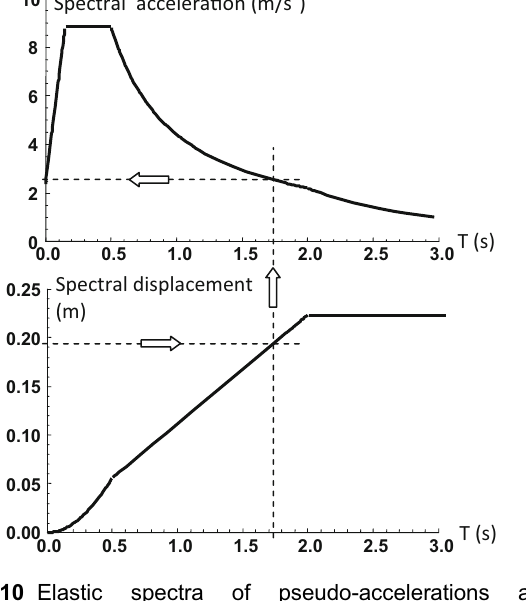
Fig. 10 Elastic spectra of pseudo-accelerations and displacements.